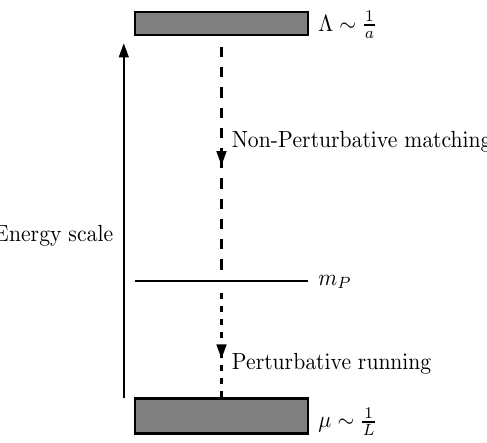
Figure 1 . The scales involved in our FSS strategy with the on-shell renormalisation scheme. Starting from the lattice theory at scale (cid:3) 1 =a , we non-perturbatively match bare quantities to / the on-shell renormalisation scheme at m P , from where we perform a leading-order perturbative running to the energy scale (cid:22) 1 =L (cid:24)